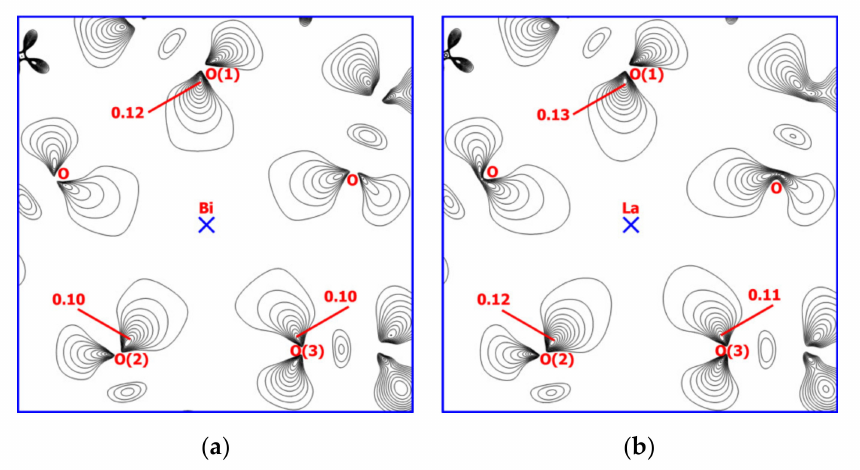
Figure 8. Deformation Electron Density maps in the plane of the oxime atoms O(1), O(2), and O(3): ( a ) For [Bi(15-MC Cu(II)Tyrha -5)] 3 + ; ( b ) For [La(15-MC Cu(II)Tyrha -5)] 3 + . The contour lines start from 0.01 a.u. with step of 0.01 a.u. The maps are built at the same scale. The level of DFT calculations is PBE / x2c-TZVPall // SR-PBE / rL2.